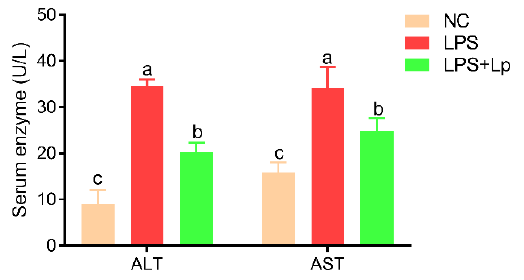
Figure 1. Effect of L. paracasei CCFM1223 pretreatment on serum ALT and AST levels in LPS-treated mice (n = 8). Values with different letters are significantly different ( p < 0.05).